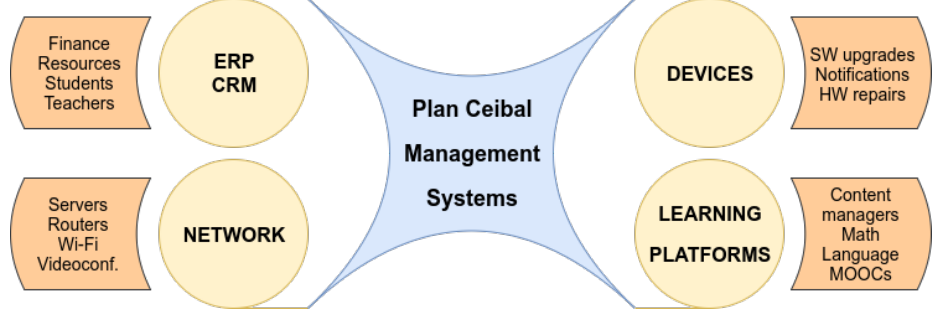
Figure 1. Management systems at Plan